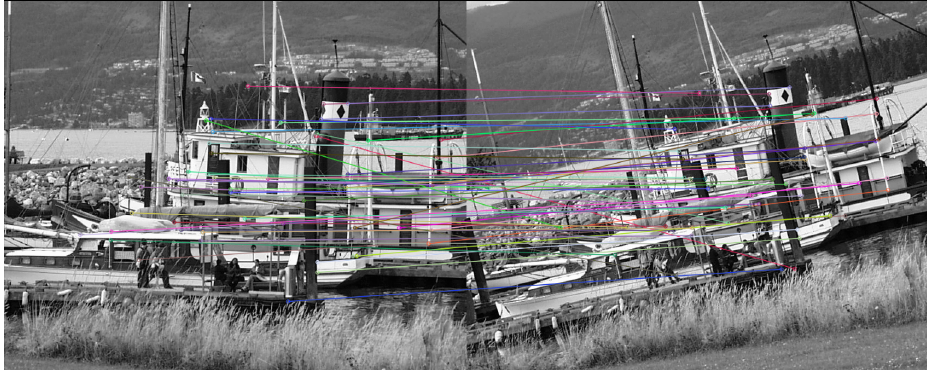
Figure 12. Feature matching results using the proposed architecture on images from the Boat sequence from the Oxford Affine Covariant Feature dataset (the matching part was performed in the CPU). The translation error measure compares the angle difference between the true rotation and the rotation estimated by Equation (13). The error is expressed in